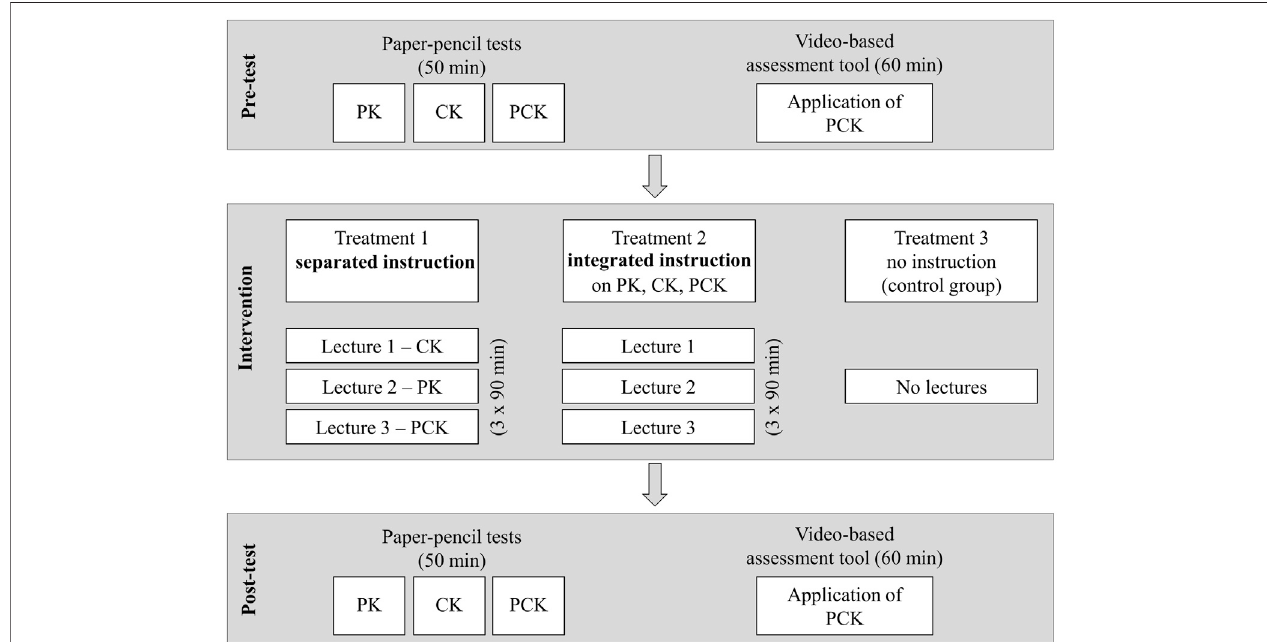
FIGURE 1 | Design of the